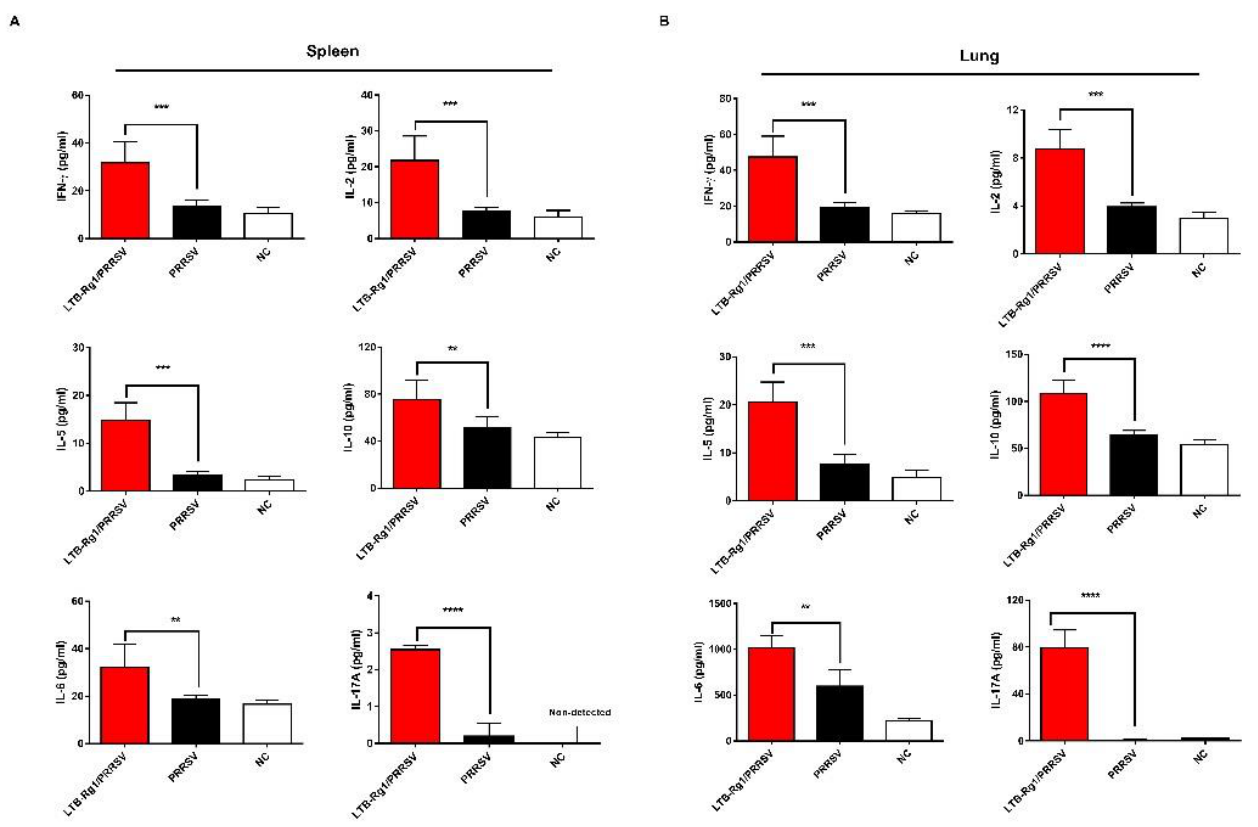
Figure 7. LTB-Rg1 significantly increased cytokine production. Mice ( n = 6/group) received PRRSV vaccine without or with LTB-Rg1. Non-immunized animals served as negative controls. On day 35 post-priming, splenocytes and lung cells were prepared and co-cultured with PRRSV antigen for 48 h. ( A ) Cytokines in the supernatant of splenocytes were tested using ELISA. ( B ) Cytokines in the supernatant of lung cells were measured. Data are expressed as means ± SD. ** p < 0.01, *** p < 0.001, **** p <